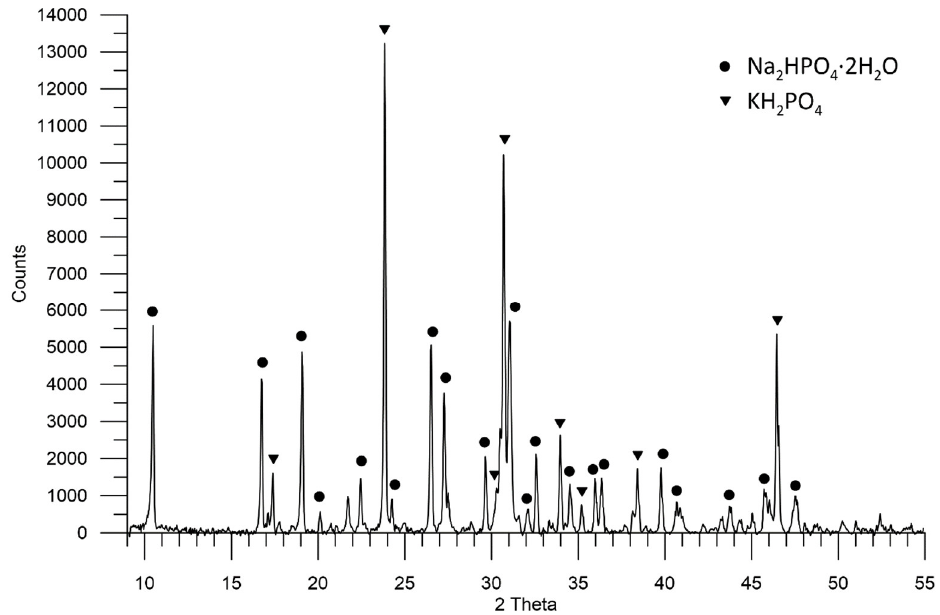
Figure 2. A diffractogram showing the composition of sediment 1 in the sample of waste phosphate from polyol production.